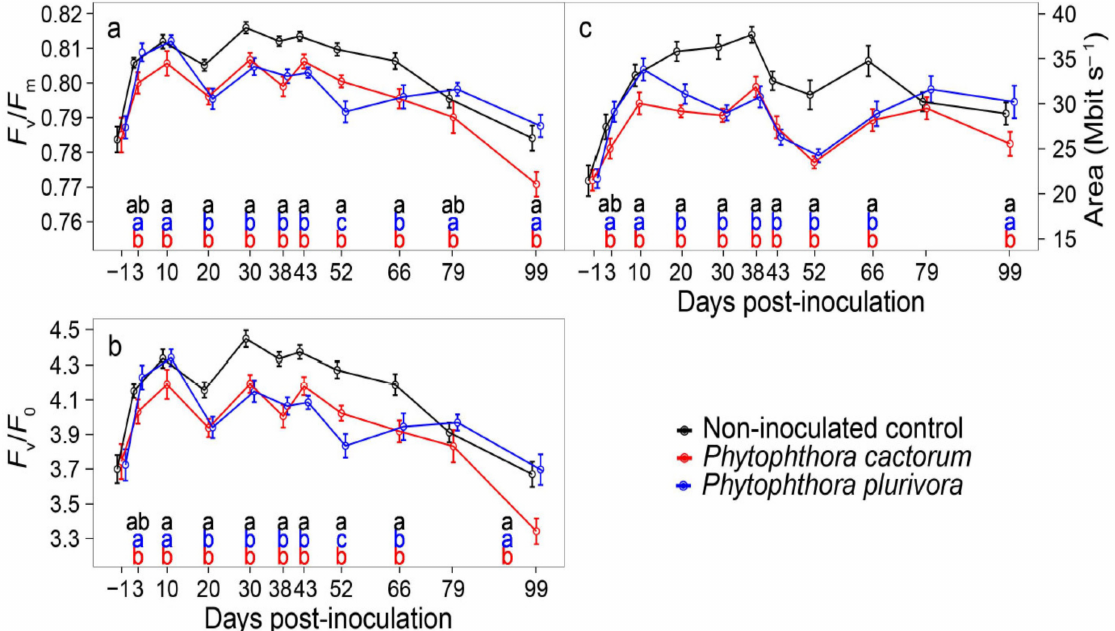
Figure 3. Chlorophyll a fluorescence yields in hybrid poplar plants inoculated with Phytophthora cactorum , Phytophthora plurivora , and non-inoculated control plants. ( a ) Seasonal results of maximum photochemical efficiency of photosystem II. ( b ) Seasonal results of variable-to-initial fluorescence ratio. ( c ) Seasonal results of potential electron acceptor capacity of photosystem II. Data represent means ± SE. Different letters indicate significant differences among the examined Phytophthora treatments ( p ≤ 0.05). No letters indicate that there were no significant differences among the treatments ( p >